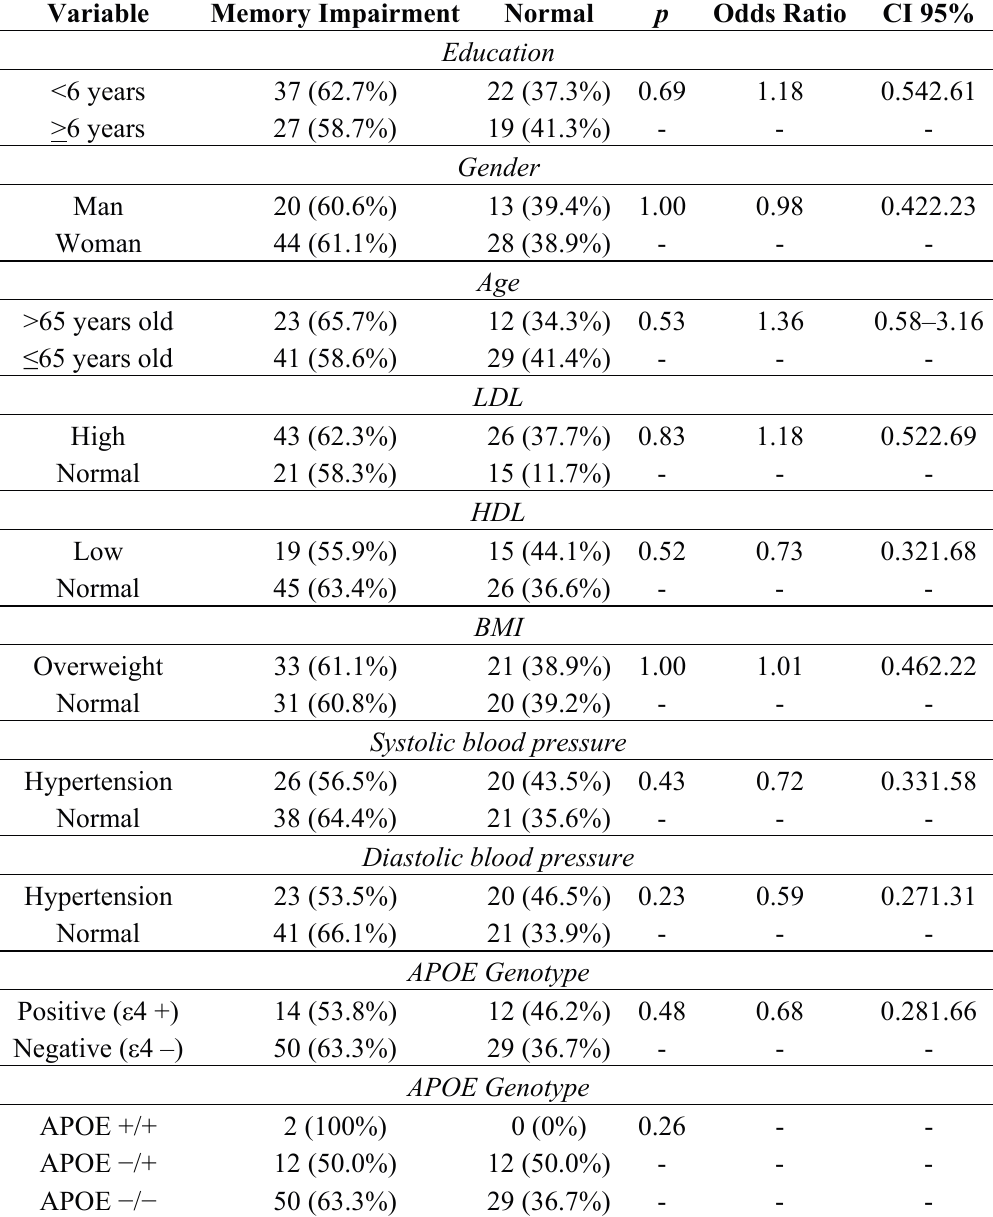
Table 2. Memory Impairment (Saving Score <80%) with Status of Demographic, Clinical, Laboratory, and